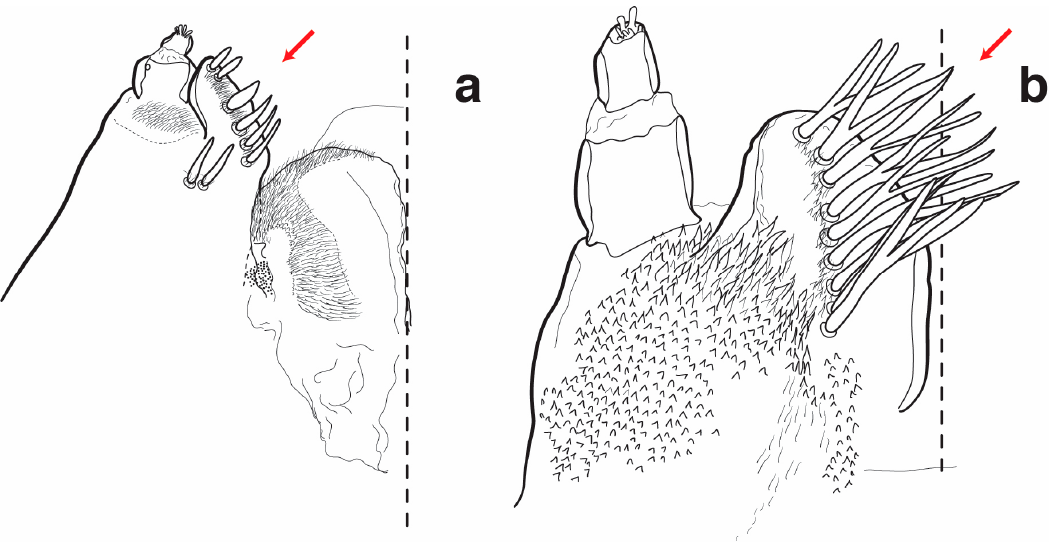
Figure 46. Hypopharynx, mala and maxillary palp, larva, dorsal view: ( a ) Cactophagus ; and ( b ) Cosmopolites .